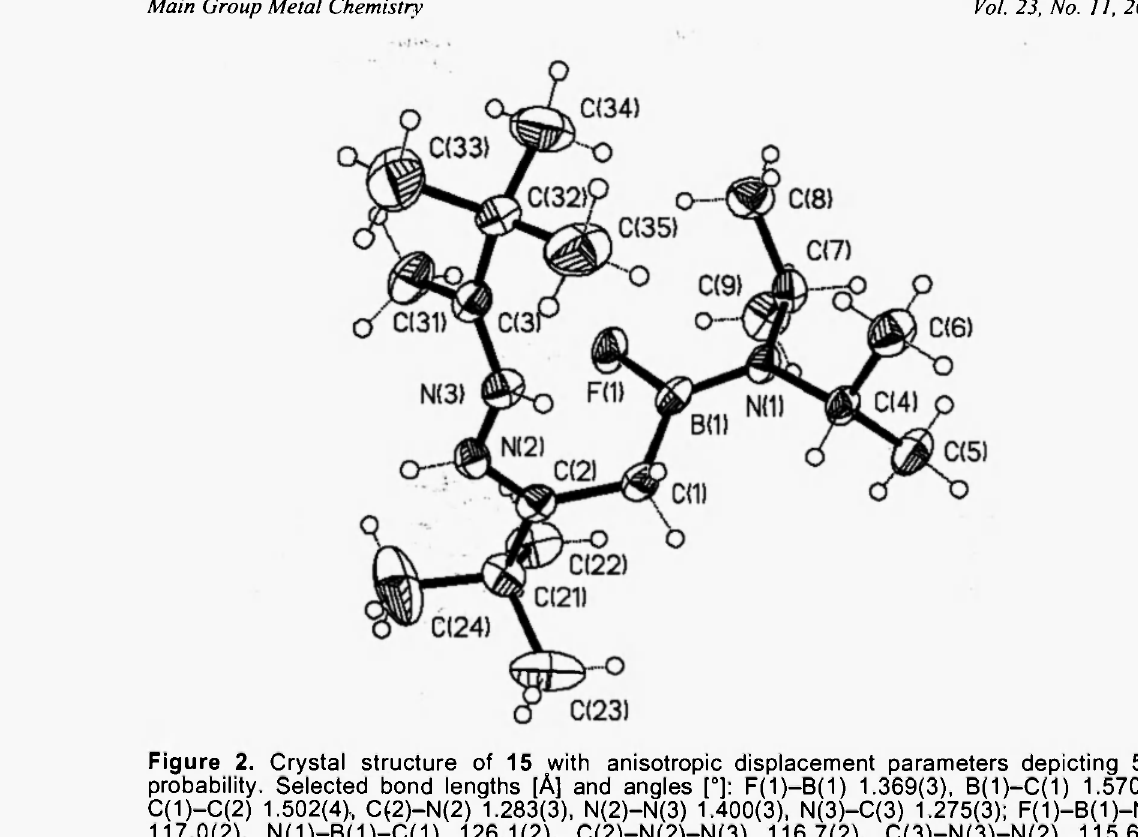
Figure 2. Crystal structure of 15 with anisotropic displacement parameters depicting 50% probability. Selected bond lengths [Ä] and angles [']: F(1)-B(1) 1.369(3), B(1)-C(1) 1.570(4), C(1)-C(2) 1.502(4), C(2)-N(2) 1.283(3), N(2)-N(3) 1.400(3), N(3)-C(3) 1.275(3); F(1)-B(1)-N(1) 117.0(2), N(1)-B(1)-C(1) 126.1(2), C(2)-N(2)-N(3) 116.7(2), C(3)-N(3)-N(2) 115.6(2), N(3)-C(3)-C(31) 122.3(3), N(3)-C(3)-C(32)